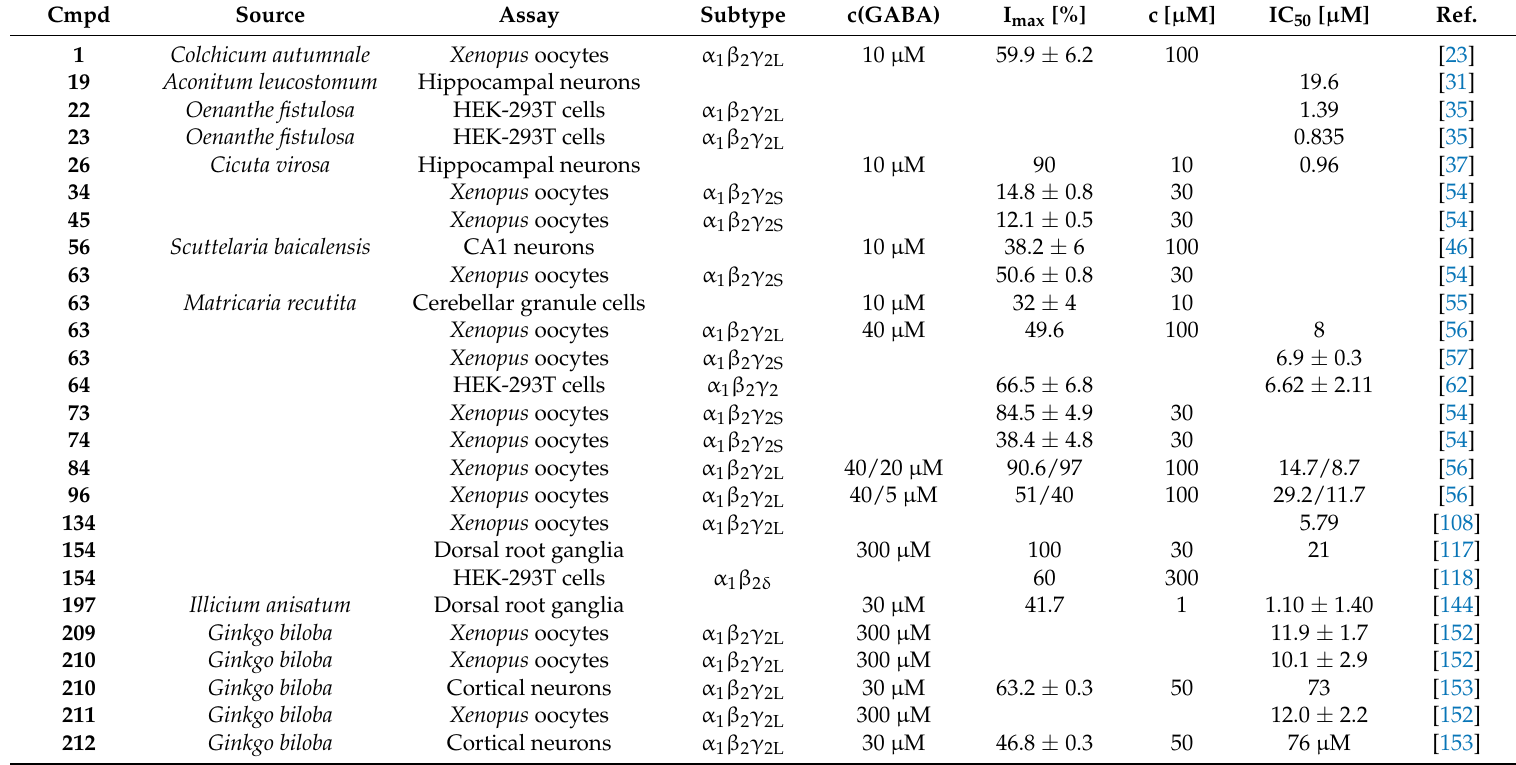
Table 1. Data from electrophysiological studies of GABA(A) receptor